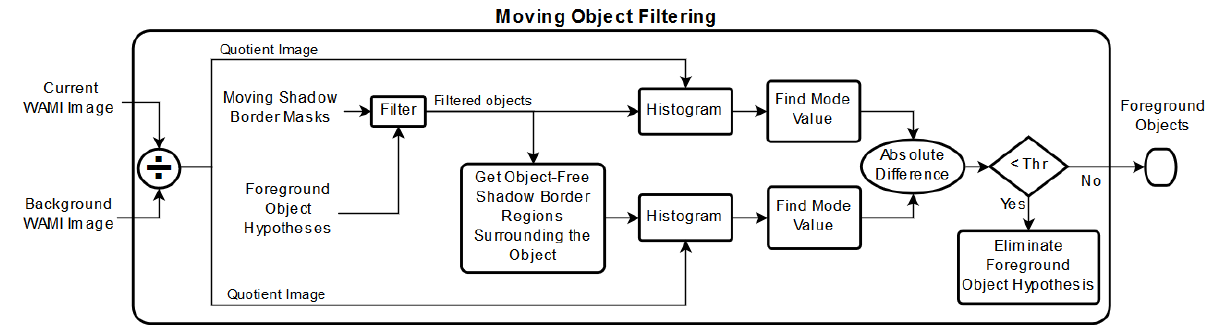
Figure 7. Moving Object Filtering Flow Chart (The overall system chart can be seen in Figure